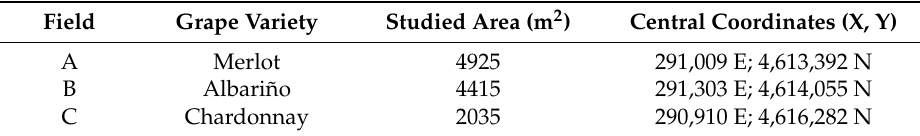
Table 1. Main characteristics of the studied fields. Coordinates are in the WGS84, UTM zone 31N reference system.